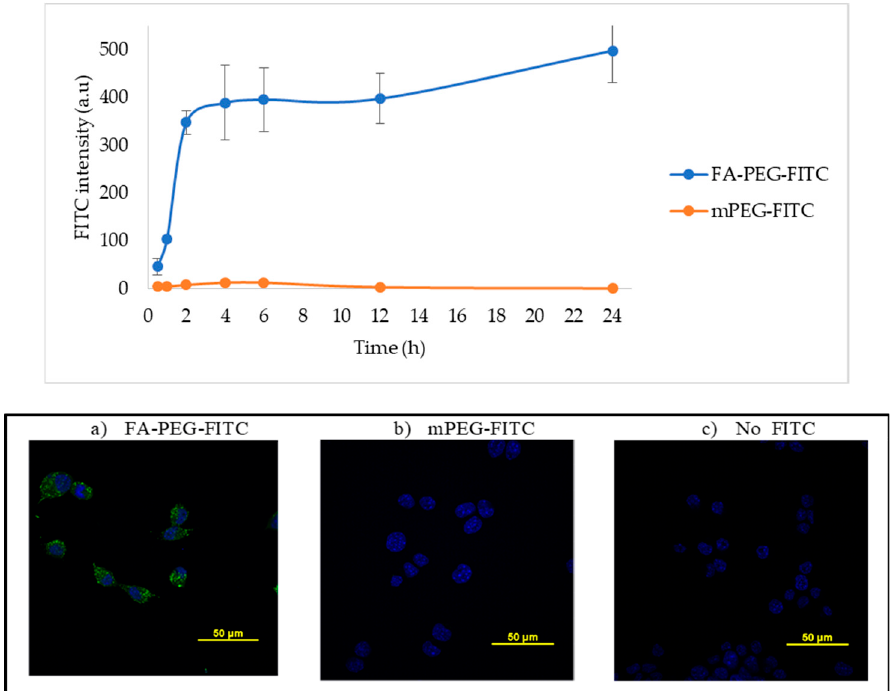
Figure 1. Lewis Lung Carcinoma (LLC) cell uptake of folic acid modified with FITC. Upper panel—the intensity of FITC fluorescence signal (Ex. 488 nm) in fixed LLC cells incubated with 50 µ M of FA-PEG-FITC and FITC-PEGm; m = methoxy control, measured by confocal microscopy at several time points and plotted. Lower panel—representative images of LLC cells after 6 h of incubation with ( a ) FA-PEG-FITC, ( b ) mPEG-FITC, or ( c ) no FITC control. Nuclear stain DAPI shown in blue and FITC in green. FITC intensity was calculated by measuring the pixel intensity of each image using Image J, n = 9.